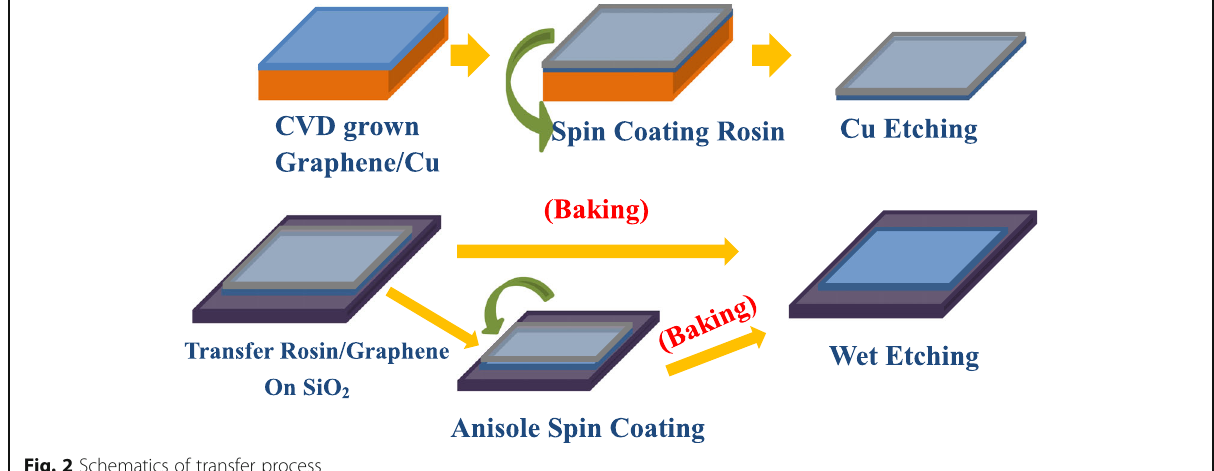
Fig. 2 Schematics of transfer process